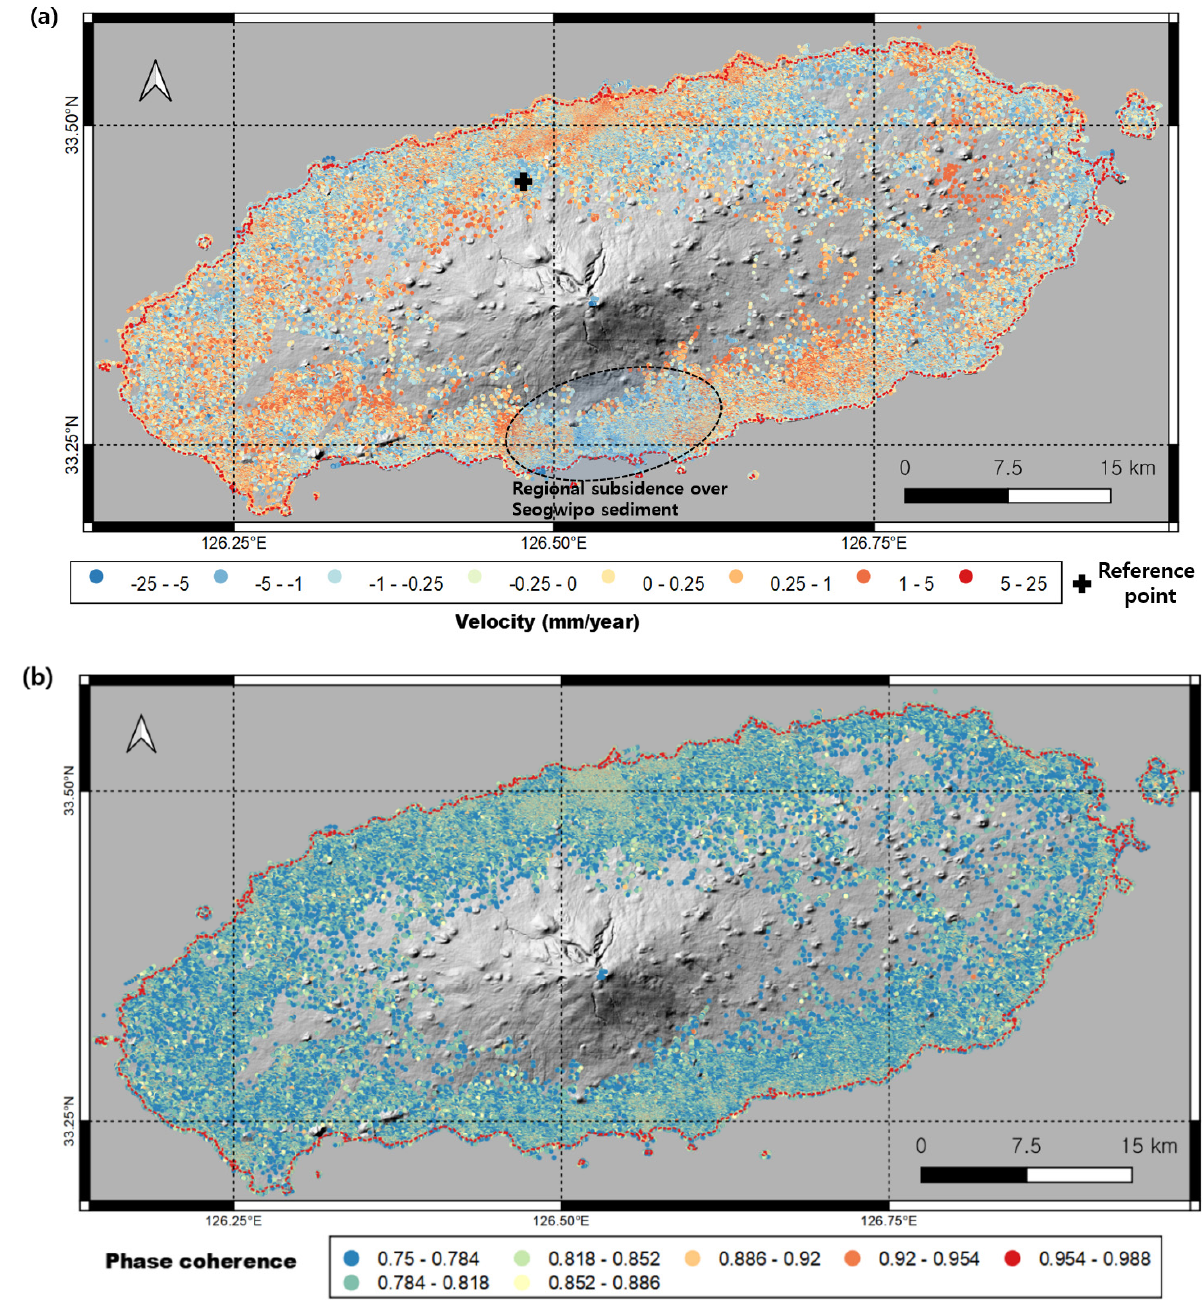
Figure 4. PS processing results over Jeju Island. ( a ) LOS deformation velocity and ( b ) average phase coherence.